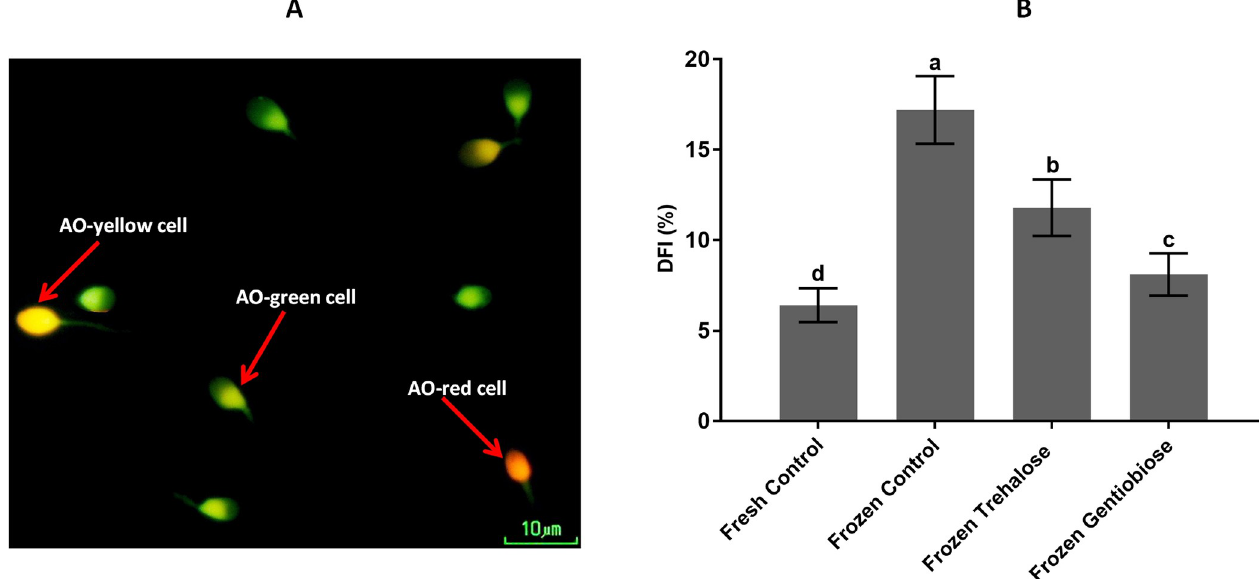
Fig 6. DNA fragmentation index was determined using AOT. Intact DNA is shown as green cells, and damaged DNA is observed as yellow and red cells by fluorescent microscopy with 100 × magnification (A). The DFI was significantly different in all of the groups (B). The assigned letters a, b, c, and d indicate significant differences (P < 0.05). Values are expressed as mean ± SD, Tukey test; n = 25.